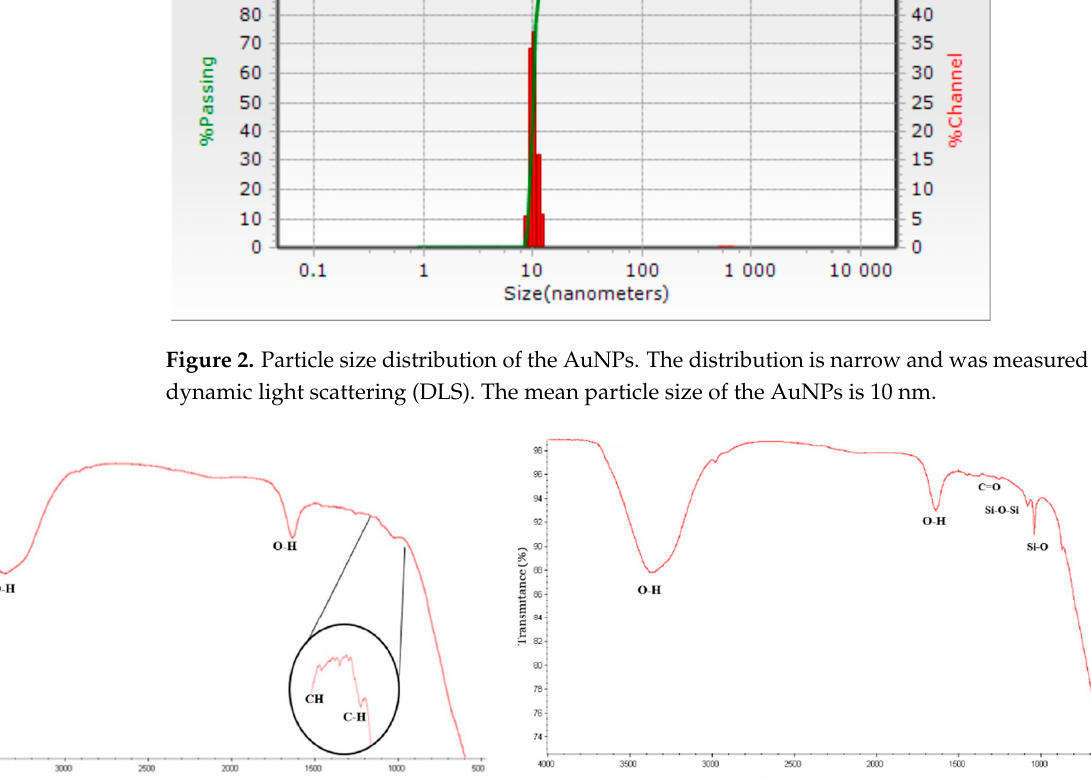
Figure 2. Particle size distribution of the AuNPs. The distribution is narrow and was measured us- ing dynamic light scattering (DLS). The mean particle size of the AuNPs is 10 nm.